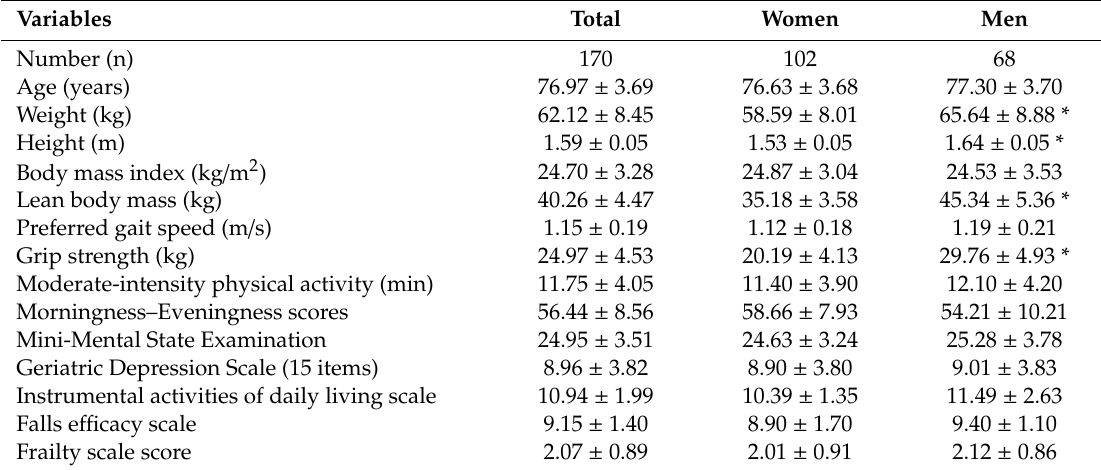
Table 1. Anthropometric, physical, and chronotype characteristics of the